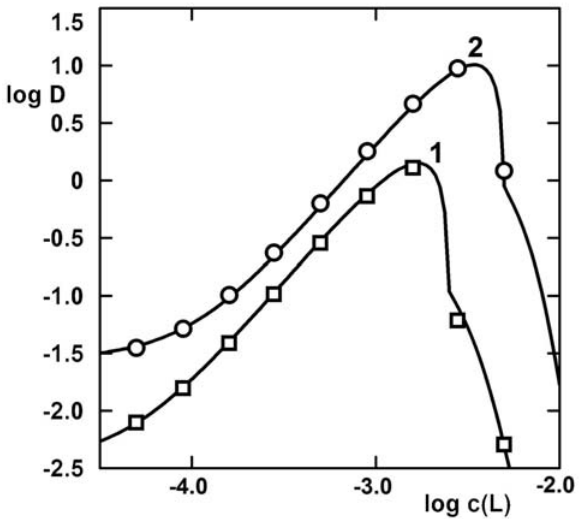
Figure 1. Log D as a function of log c(L), where L = N,N,N’,N’ -te- trabutyl-1,10-phenanthroline-2,9-dicarboxamide, for the system water – HNO –Eu 3+ (microamounts)–nitrobenzene– N,N,N’,N’ -te- 3 trabutyl-1,10-phenanthroline-2,9-dicarboxamide (L)–H + B – ; 1 c(HNO ) = 0.05 mol/L, c = 0.0025 mol/L; 2 c(HNO 3 B mol/L, c = 0.005 mol/L. The curves were calculated using the con- B stants given in Table 5.